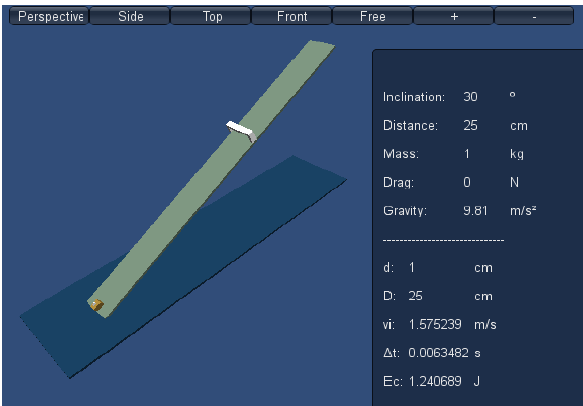
Figure 4. Virtual experiment for demonstration of basic concepts of physics.